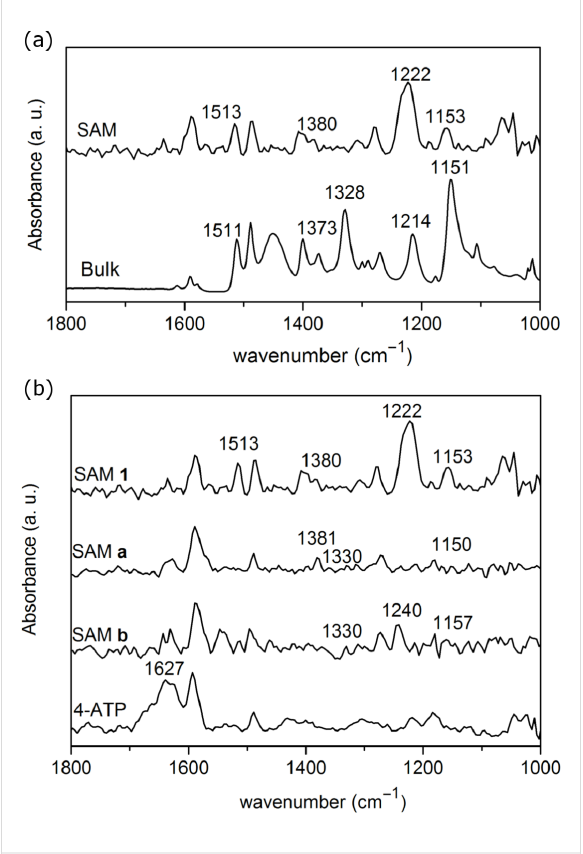
Figure 2: (a) IR spectra of sulfamide 1 in bulk (solid state) (bottom) and adsorbed on gold (top). (b) PM-IRRAS spectra of the 4-ATP SAM. The 4-ATP SAM is reacted with 4-FC 6 H 4 SO 2 NHOSO 2 -4-FC 6 H 4 (SAM b) or 4-MeC 6 H 4 SO 2 NHOSO 2 -4-MeC 6 H 4 (SAM a) and the sulfamide 1 SAM (SAM